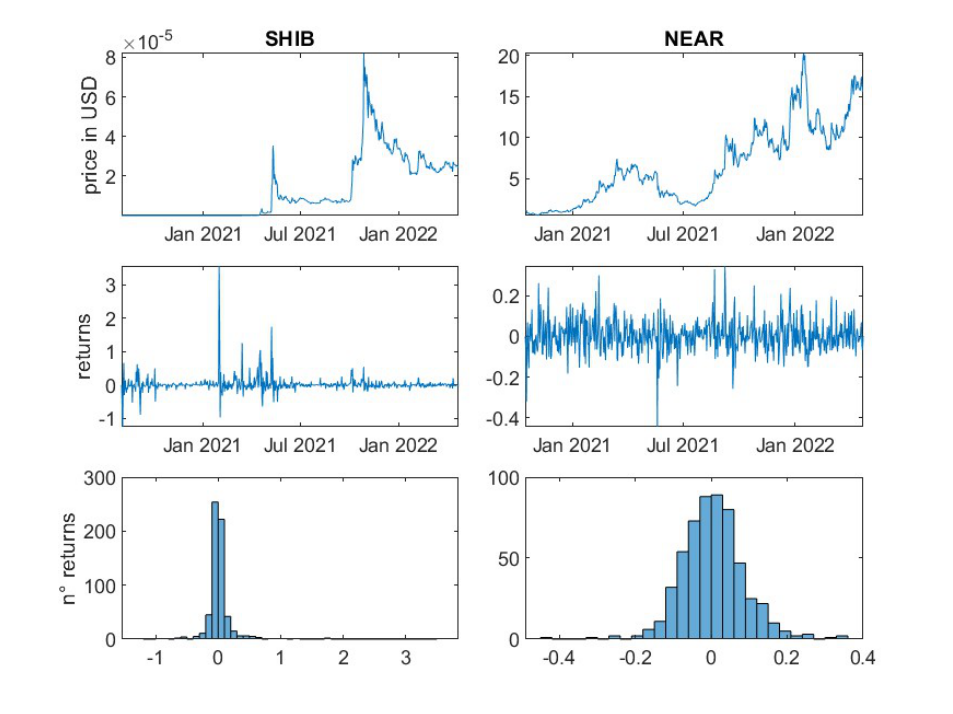
Figure A6. SHIB and NEAR daily logarithmic returns.